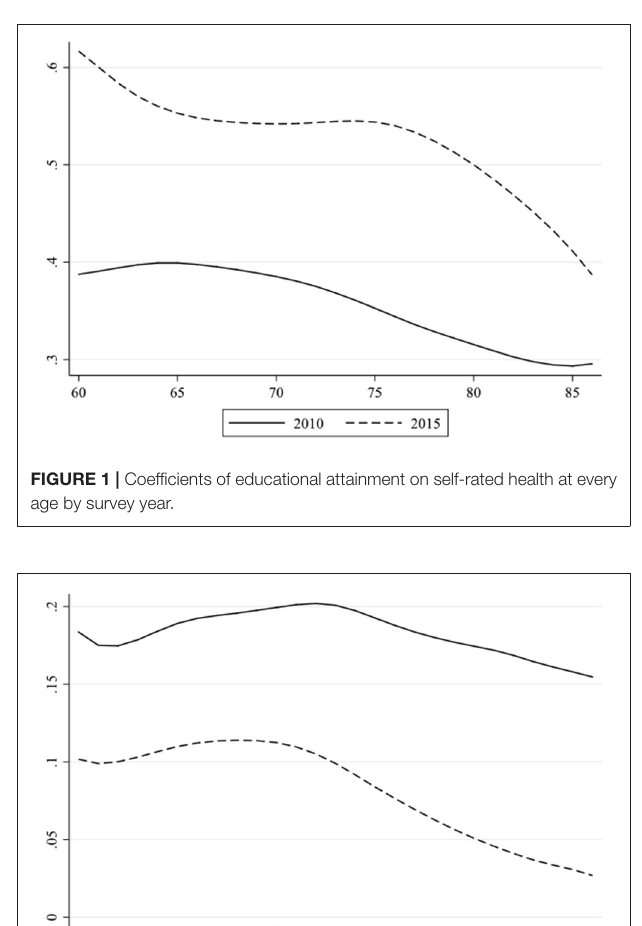
(coef. = − 0.004, p < 0.000), were significantly negative. In